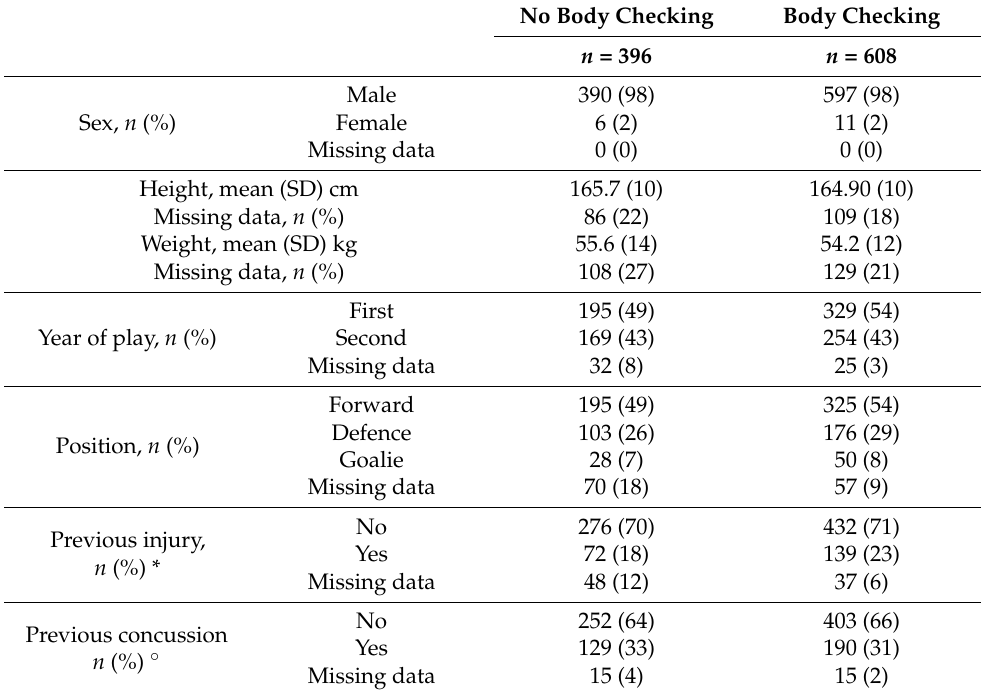
Table 3. Baseline characteristics of the two study groups.